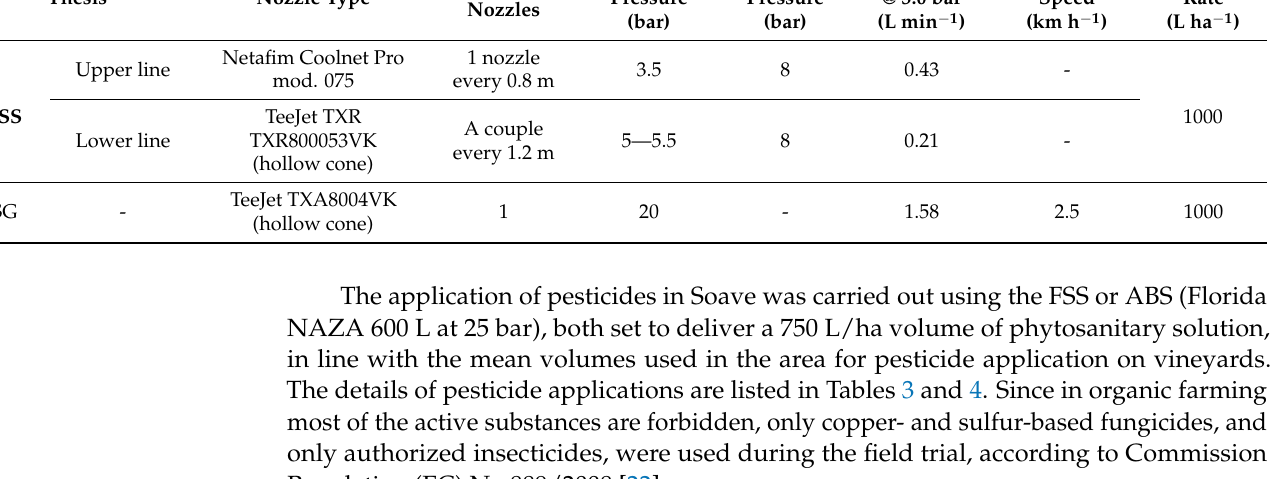
Table 2. Operating parameters used in every pesticide application in the Vidor vineyard during 2020. Thesis